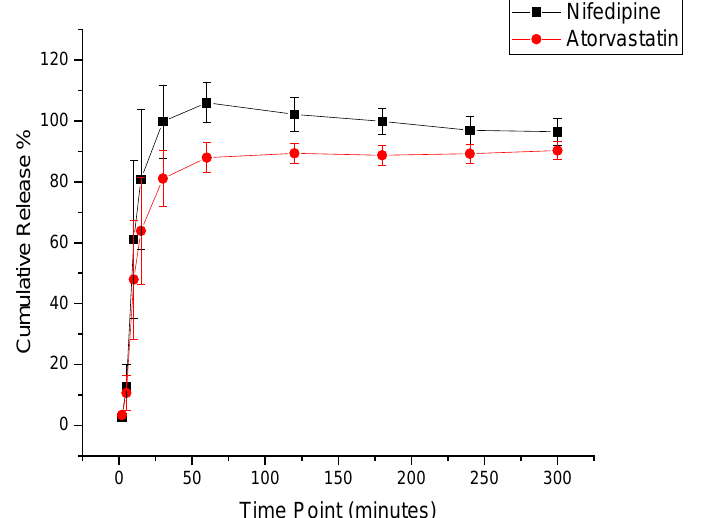
Figure 6. The release profile of the drug-loaded core–shell fibers of nifedipine and atorvastatin calcium showed a burst release at 10 min, followed by >80% release after 30 min and a complete drug release after 120 min—results represented as mean ± SD ( n = 3).